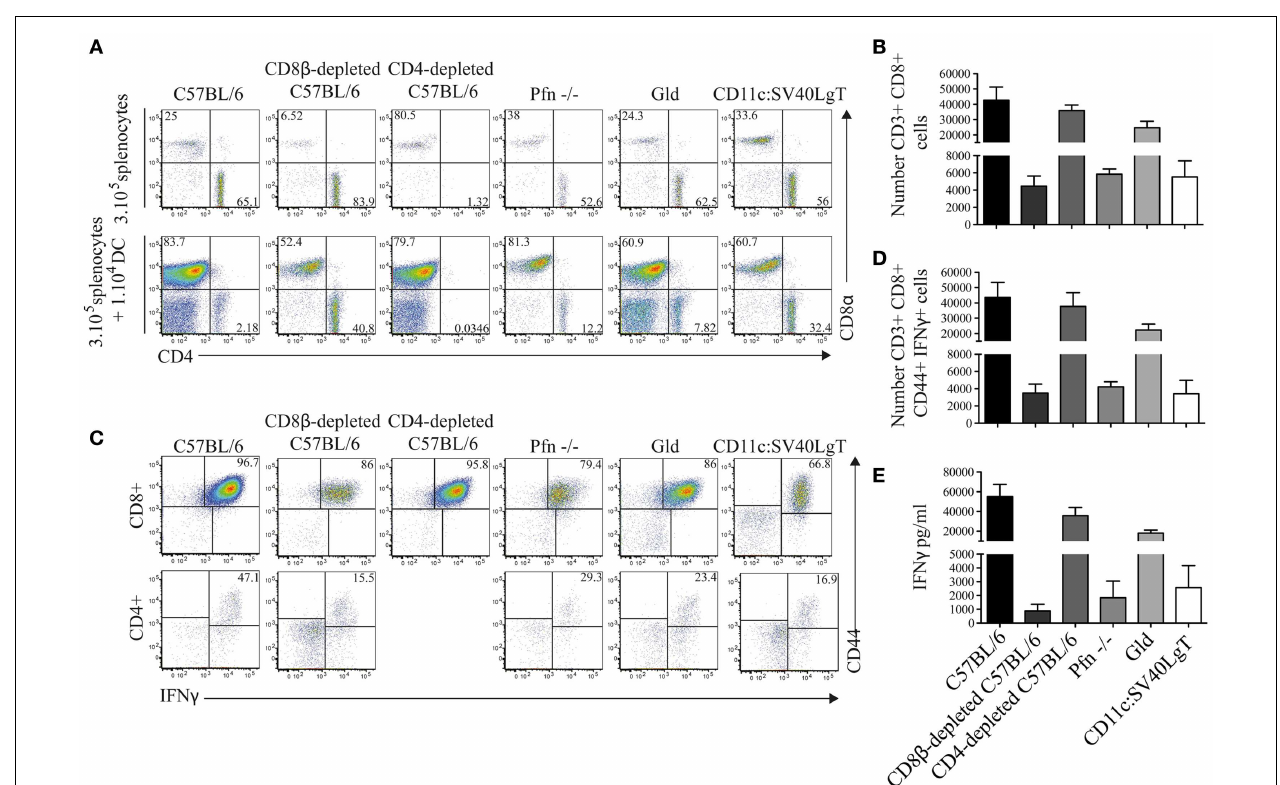
of the activation marker CD44 and the production of IFN γ were analyzed, after restimulation with the MuTuDC lines for 4days, among CD8 + CD4 − cells (upper panel) and CD4 + CD8 − cells (lower panel) after gating on single CD3 + live cells (C) and the number of CD3 + CD8 + CD4 − CD44 + IFN γ + cells was quantified (D) . (E) The secretion of IFN γ was assessed by ELISA in the supernatant of culture after restimulation with the MuTuDC lines for 4days. Mean ± SD is shown. Results are representative of two independent